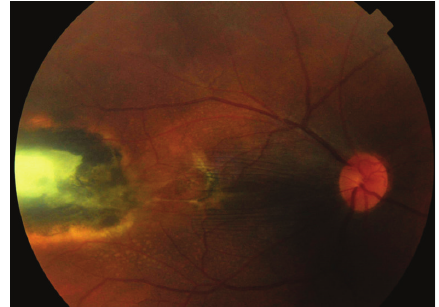
Figure 2: Color photo of the right eye showing temporal exit with macular dragging.